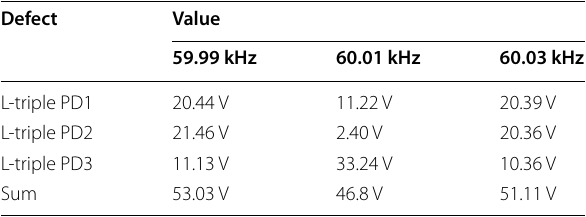
Table 2 Output voltage values at peak frequencies and their sums under